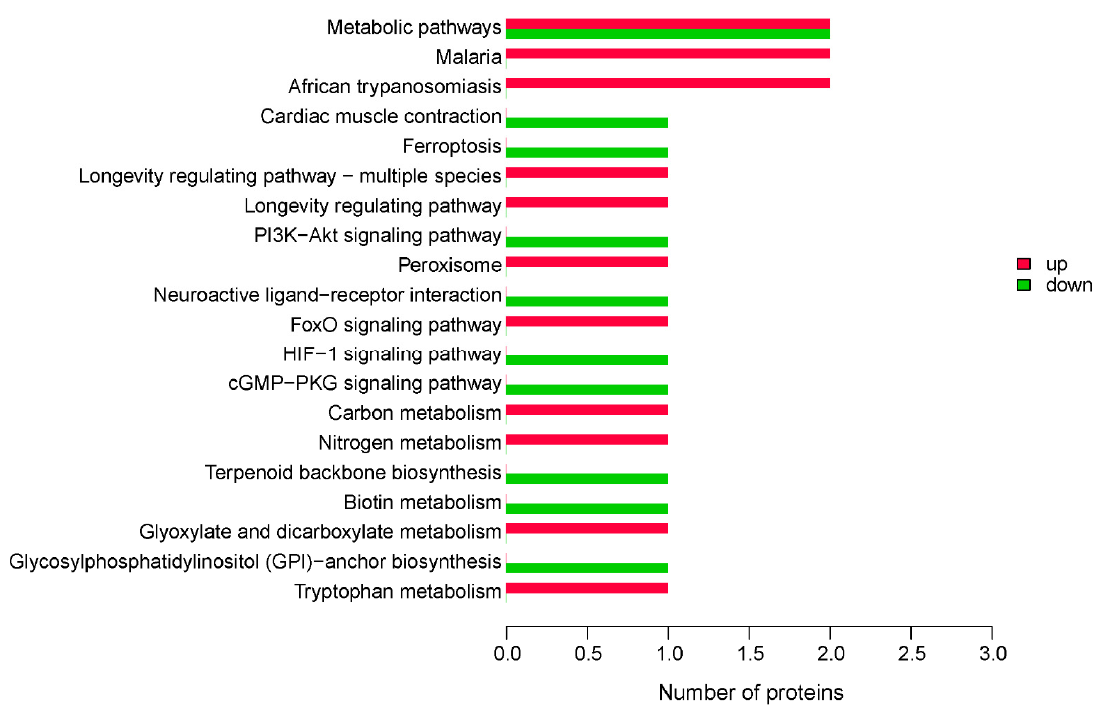
Figure 4. Kyoto Encyclopedia of Genes and Genomes (KEGG) pathway annotation analysis of 35 DEPs. Up represents proteins that are upregulated between experimental and control groups, and down represents proteins that are downregulated.